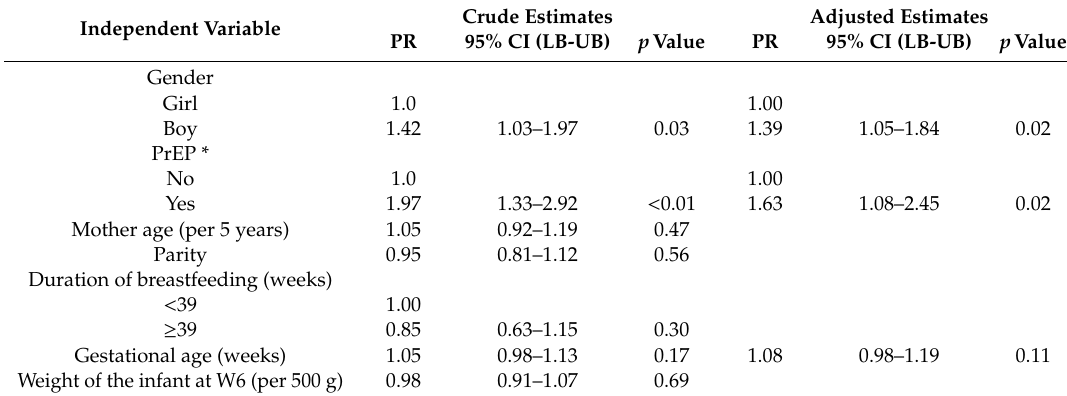
Table 7. Risk factors associated with mtDNA depletion ( ≥ 50% reduction) after six months of PrEP in CHEU from South